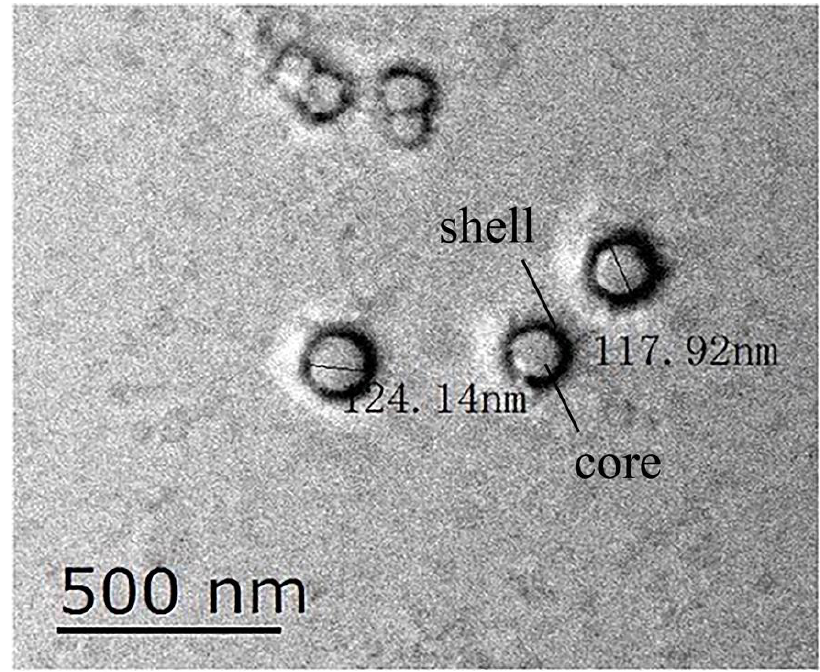
Figure 4. Transmission electron microscope analysis diagram for the dispersion particles.